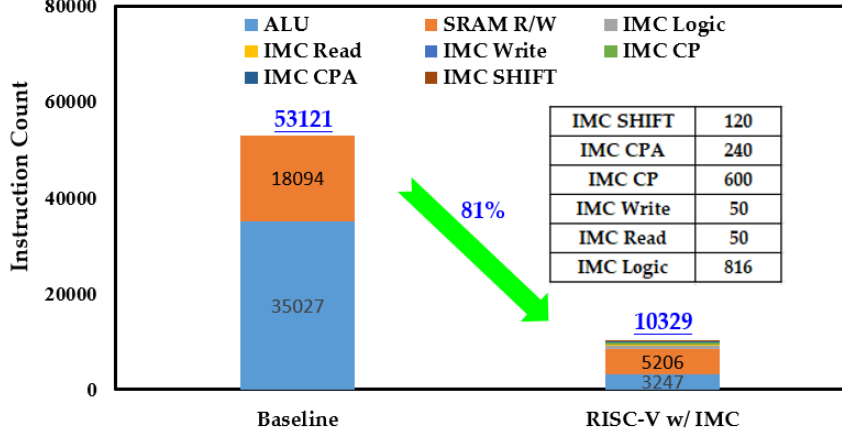
Figure 12. Comparison of energy consumption in overall Keccak process. 5.5. Comparison with Mainstream Mining Platforms and SRAM-Based IMC Table 7 gives a comparison of the proposed memristor-based IMC with mainstream mining platforms and SRAM-based IMC. For the CPU, GPU, and ASIC, we selected i5 2500k from Intel, Tesla S1070 from Nvidia, and Antminer S4 from Bitmain, all of which were implemented in the 28/32-nm technology node. The performance was measured by the hash rate, i.e., hash operations performed in one second (H/s). The SRAM-based IMC was evaluated using the same method with the memristor-based one in this work. Table 7. Comparison of memristor-based IMC with central processing unit (CPU), graphics processing unit (GPU), application-specific integrated circuit (ASIC), and SRAM-based IMC. Mining Platform